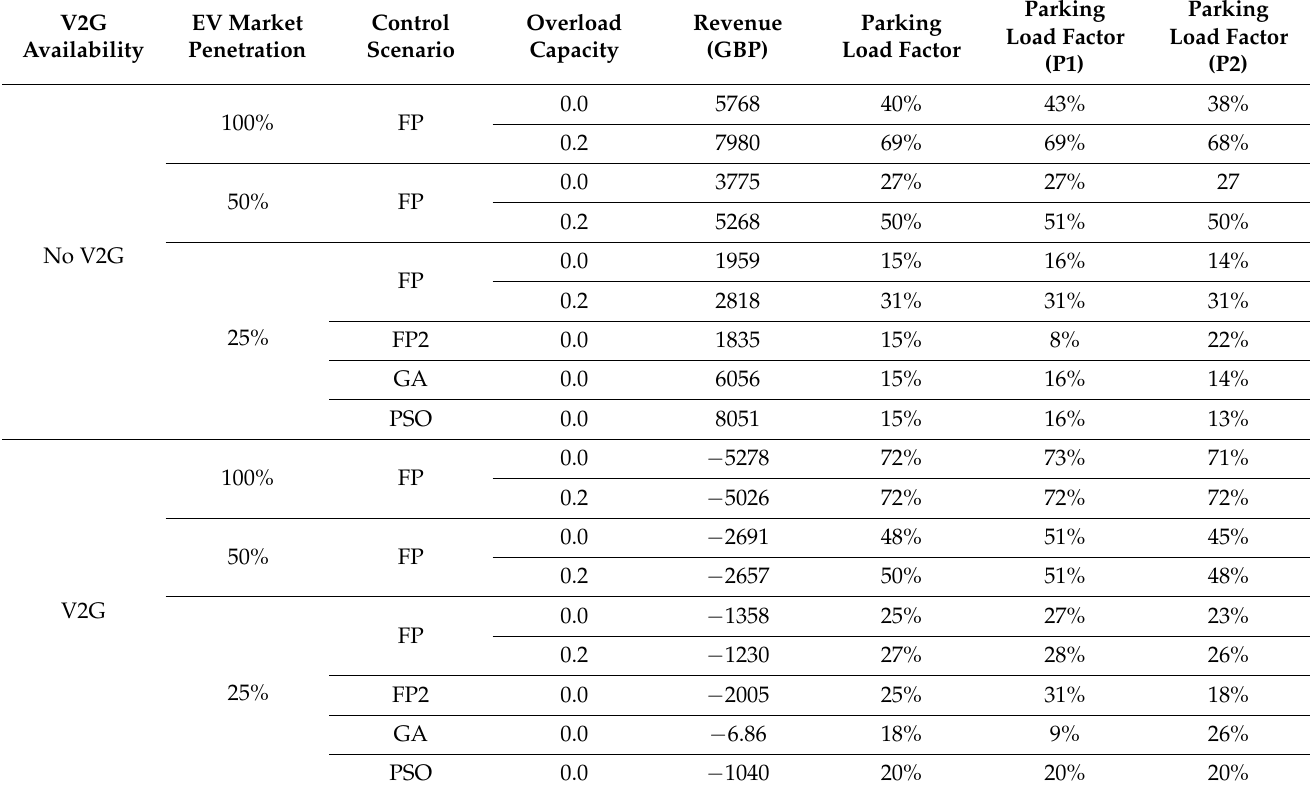
Table 2. Revenue performance and parking load factors for various parameter combinations.